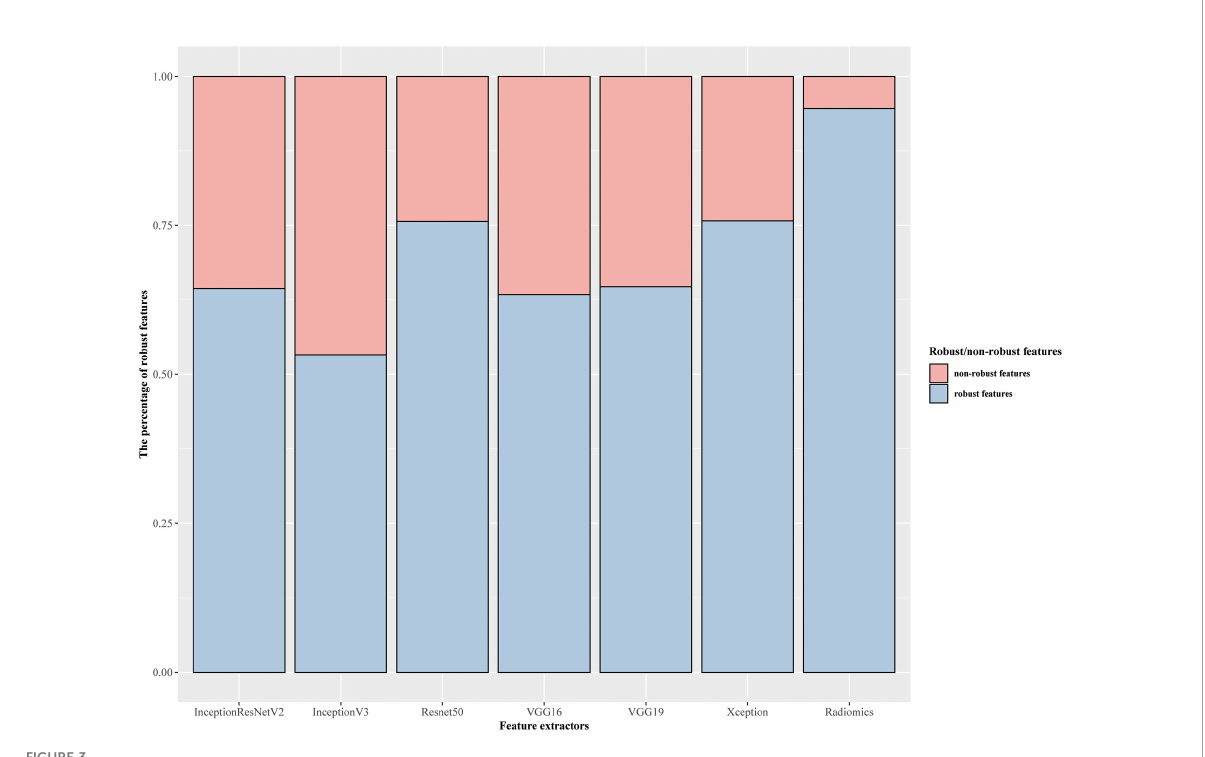
FIGURE 3 Overall percentage of robust features against image